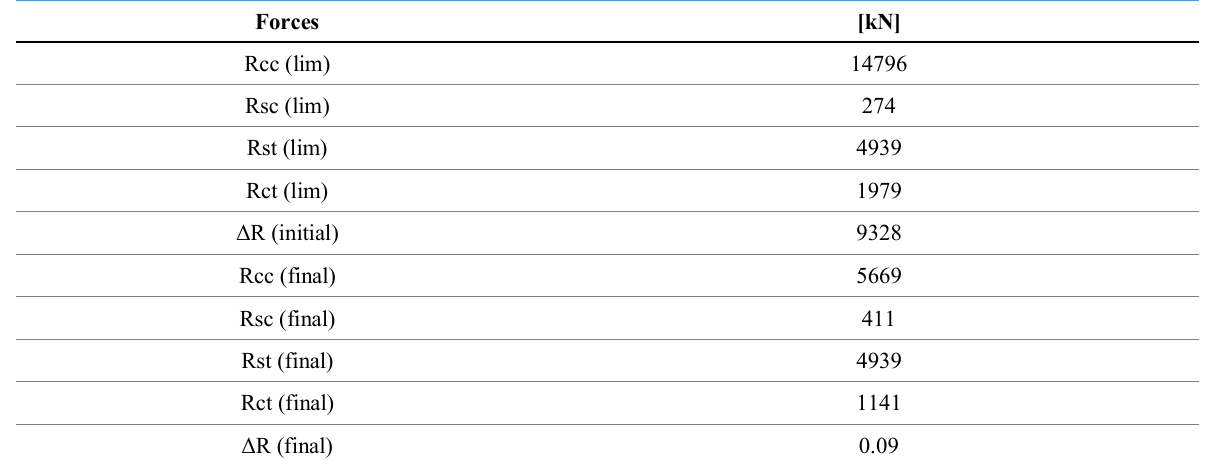
Table 3. Design data for Graybeal